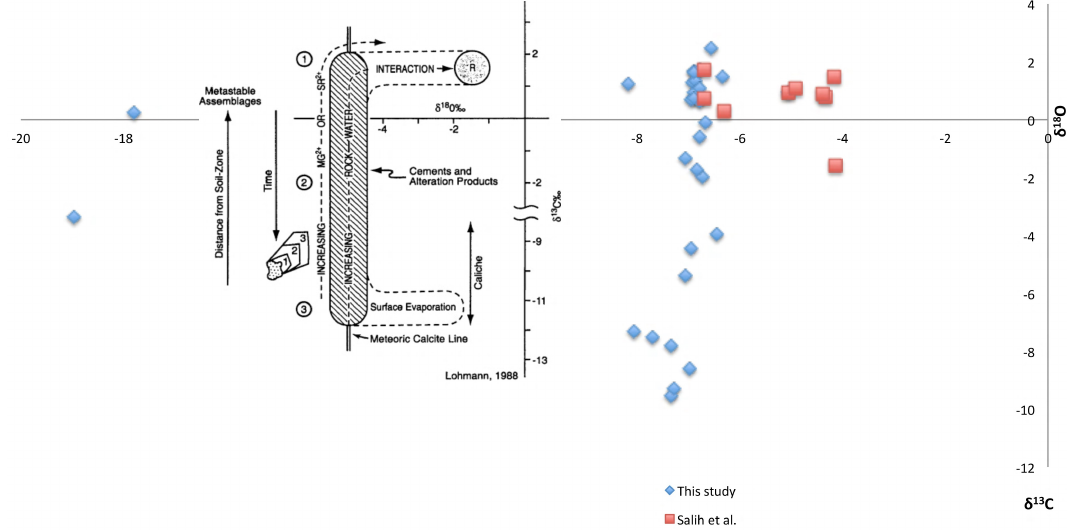
Figure 14. δ 18 O VPDB – δ 13 C VPDB isotope data of Bekhme Formation from Spelek–Sulauk area (blue points). Variable data of carbon compared to oxygen isotope, and the overlapping of recent